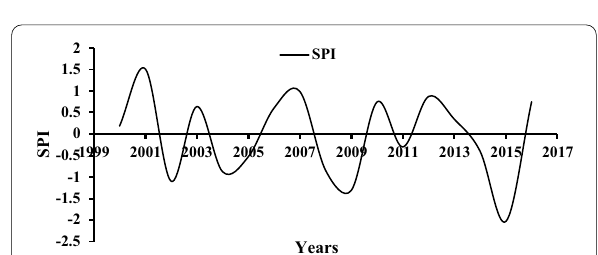
Fig. 11 Temporal trend of Standard Precipitation Index (2000 to 2016 )